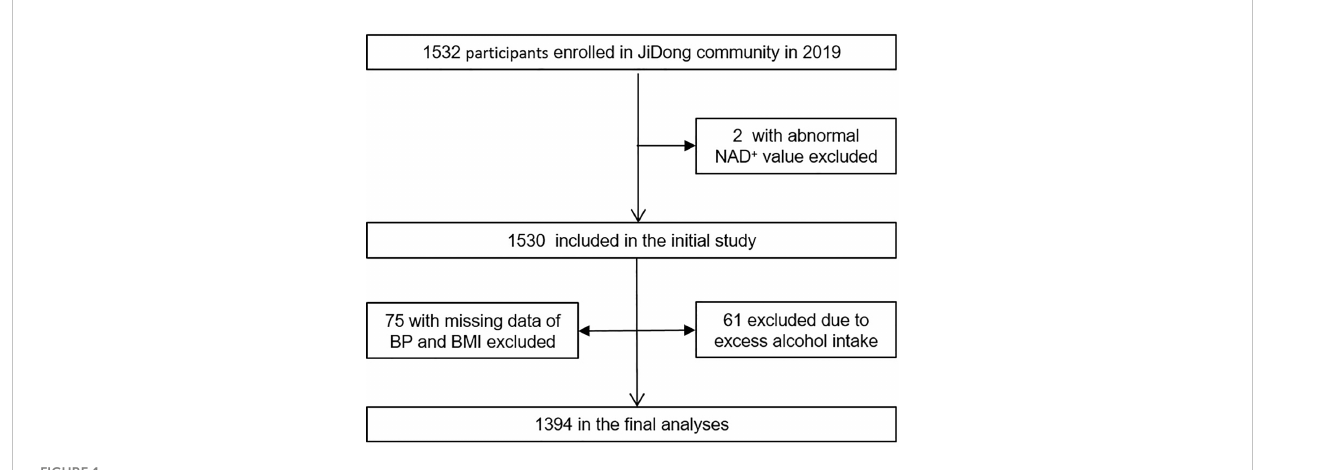
FIGURE 1 Flow chart of this study. BP, blood pressure; BMI, body mass